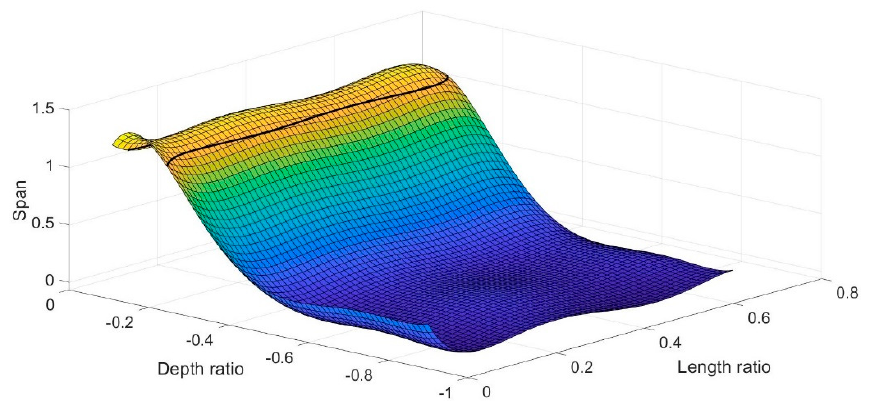
Figure 8. Intersection curve for span = 1.18%.